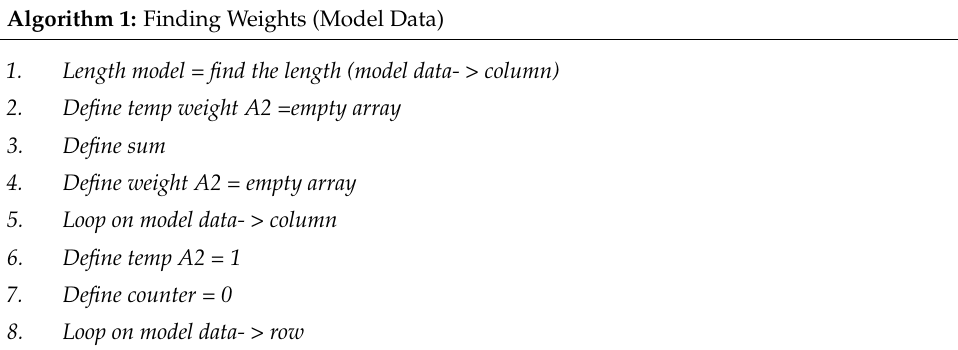
Table 3. Calculating weights of factors and alternatives. Algorithm 1: Finding Weights (Model